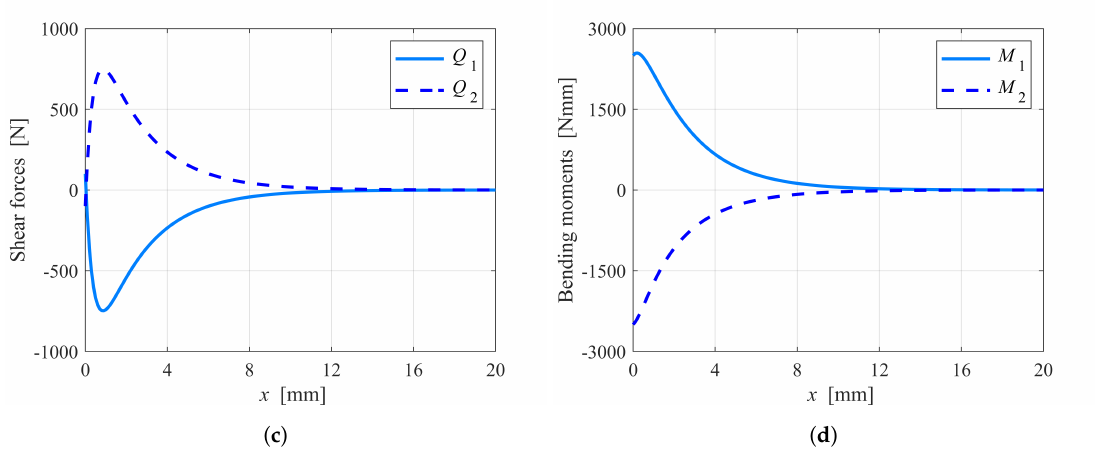
Figure 5. UD//CP specimen: ( a ) interfacial stresses, ( b ) axial forces, ( c ) shear forces, and ( d ) bending moments in the crack tip neighborhood.